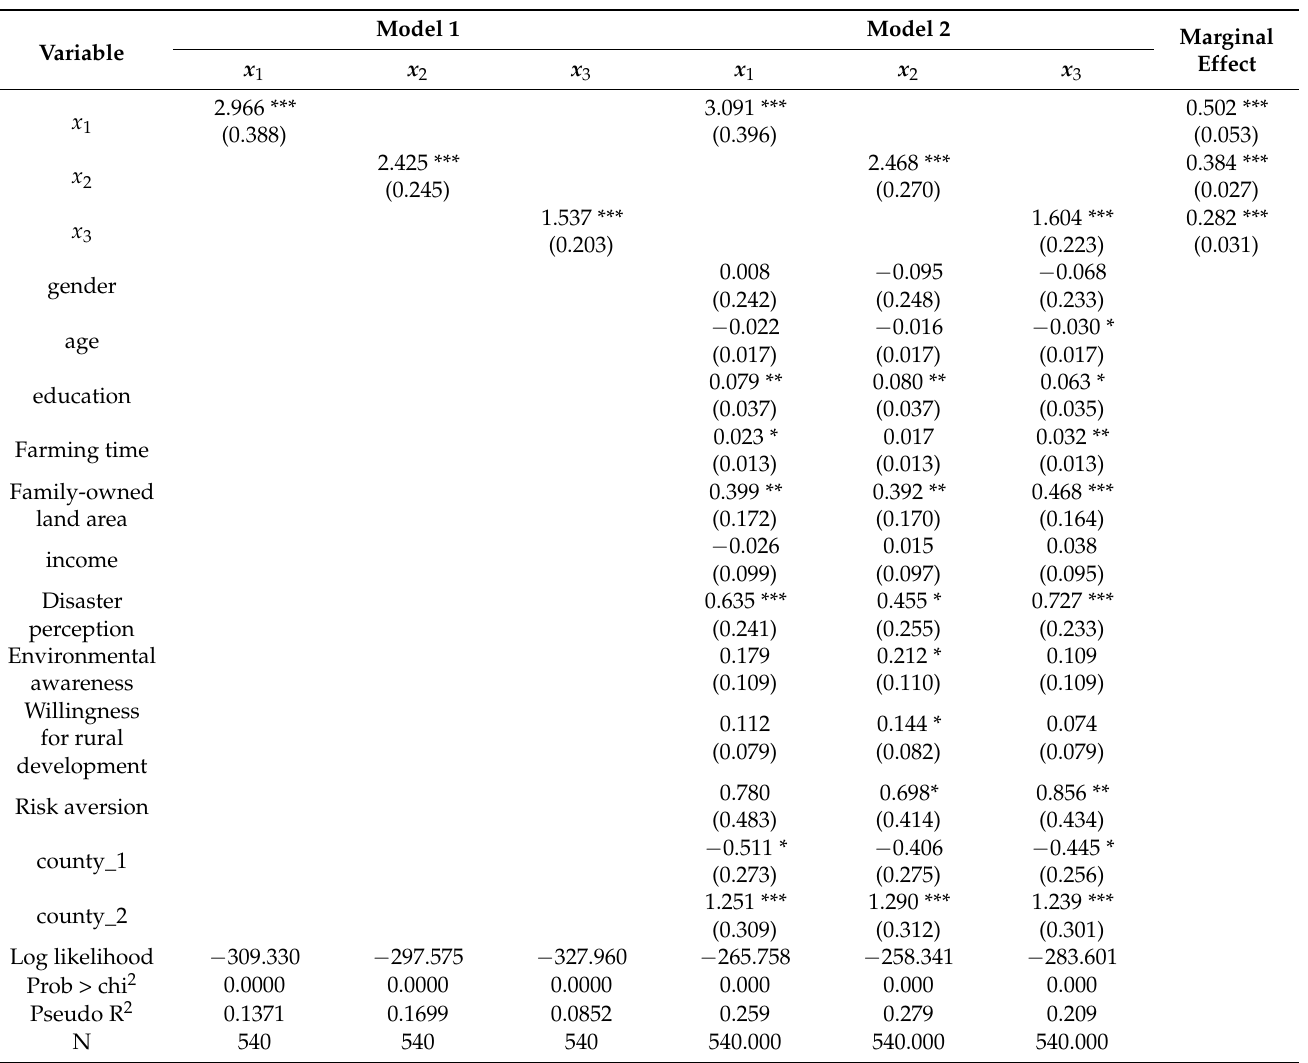
Table 2. Results of the binary logistic